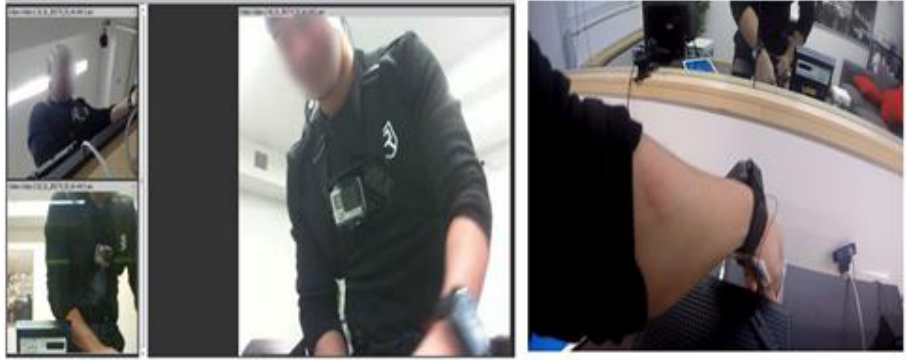
Figure 4. Three cameras were installed around the task area ( Left ) and 1 Go Pro camera on the chest of the participant ( Right ).